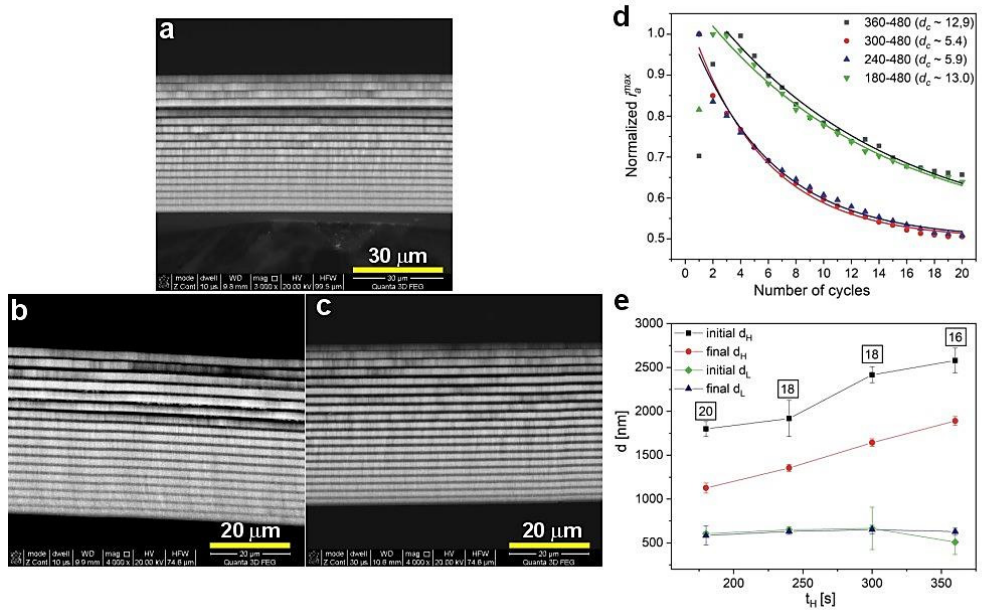
Figure 8. BSE images of the samples PAA_300-480 ( a ), PAA_240-480 ( b ), PAA_180-480 ( c ), normalized i amax as a function of number of cycles ( d ) and initial and final layer d H and d L thickness as a function t H ( e ); in black squares—the number of d H + d L pairs.